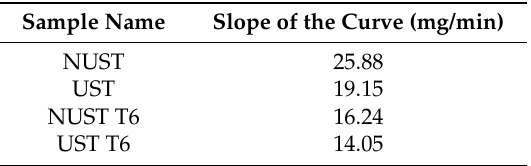
Table 3. Slope of the cumulative mass loss curves.